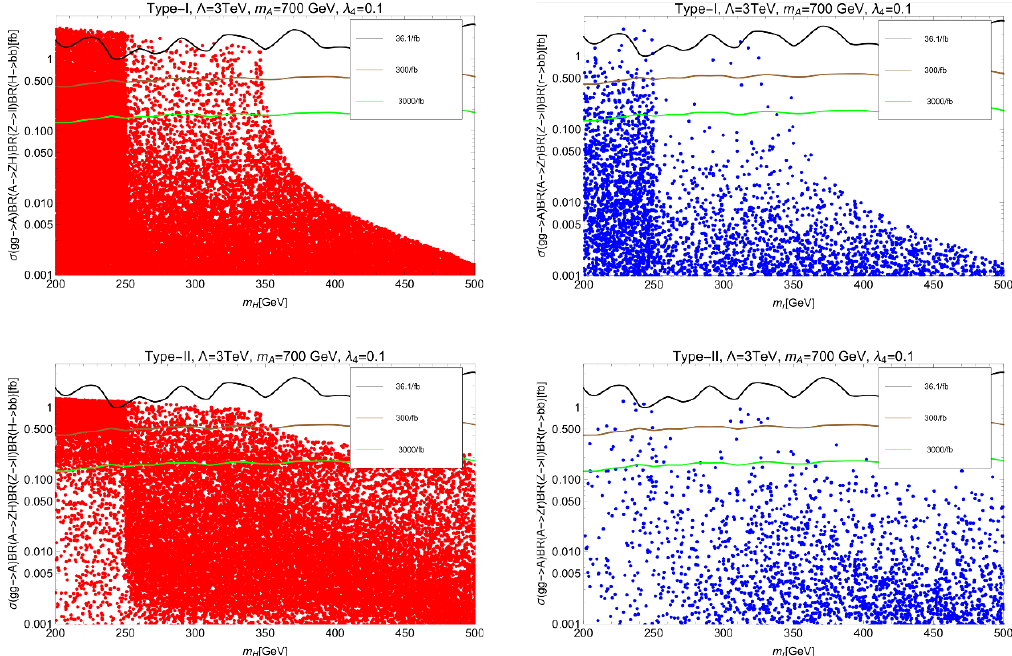
Figure 10 . The observable (cid:27) ( gg ! A ! ZX ) BR ( Z ! l + l (cid:0) ) BR ( X ! b (cid:22) b ) as a function of the resonance mass with X = H (red), r (blue) for type-I (top) and type-II (bottom) models. We (cid:12)xed (cid:3) = 3 TeV, m A = 700 GeV and (cid:21) 4 = 0 : 1. Due to the custodial symmetry, the charged scalar mass is identical to the pseudoscalar mass, whose value is given above each (cid:12)gure. The heavy neutral Higgs (radion) mass is varied from 200 to 1000 GeV in the right (left) (cid:12)gures and the values of (cid:11) and (cid:12) are chosen to be consistent with the constraints of (cid:12)gure 5. The solid lines represent current and future upper bounds at the